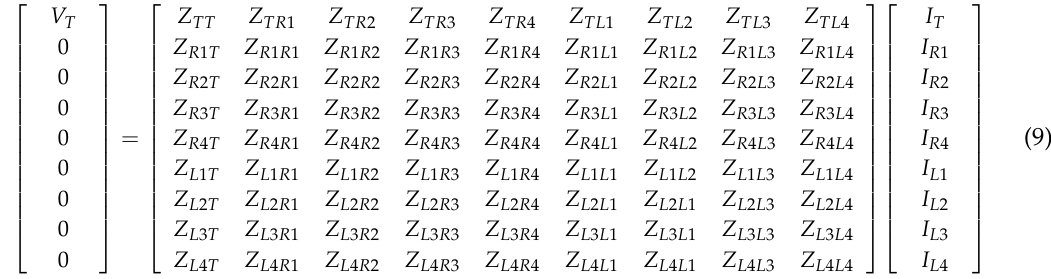
Figure 6. Equivalent circuit of Selective MRWPT system with Compensation.